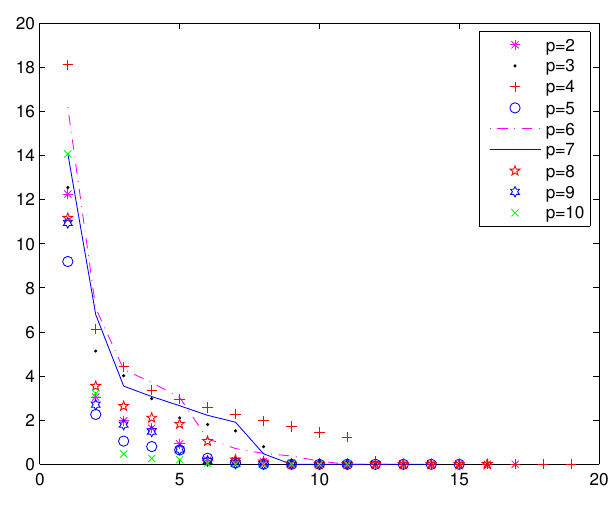
Figure 3. Numerical results for Example 2 by Method 1. The x -axis represents the iteration step; the (cid:107) F ( x , y ) (cid:107) 2 . y -axis represents θ ( x , y ) = 1 2